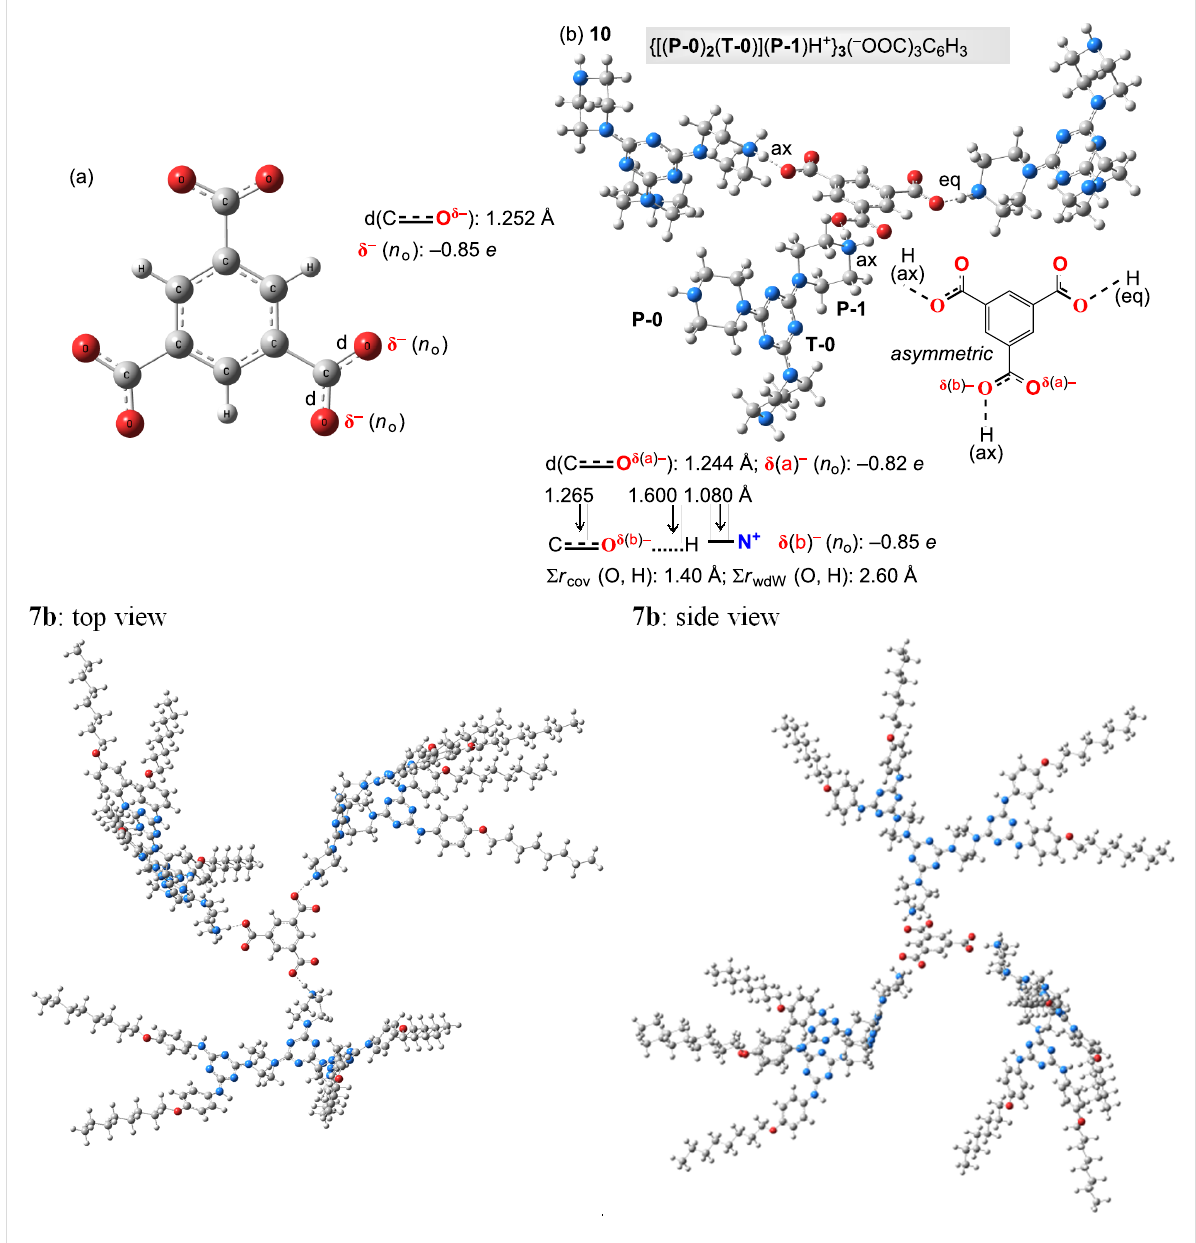
Figure 7: The DFT optimised geometry at M062X/def2-TZVP level of theory of trimesic tris-carboxylate anion (a), of model G-1 dendrimer 10 (b) and of G-2 dendrimer 7b in DMSO.